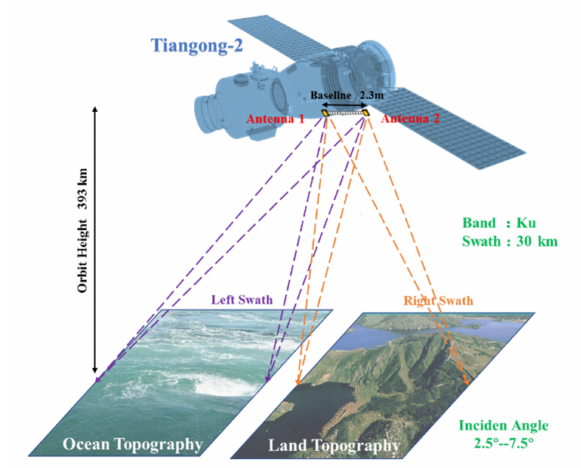
Figure 1. Schematic diagram of the Tiangong-2 InIRA